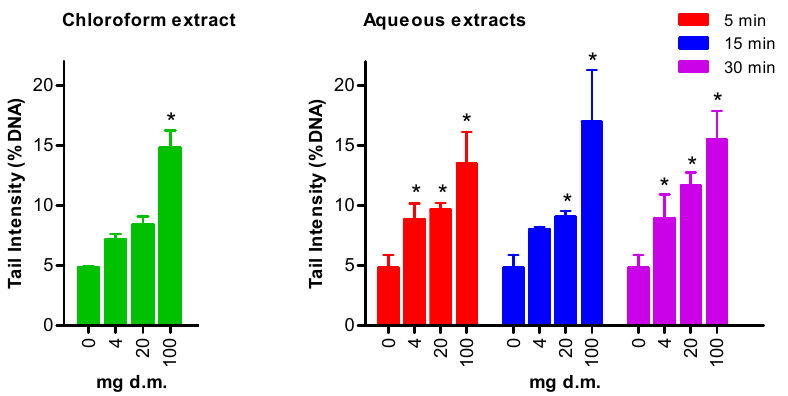
Figure 2. Primary DNA damage in HepG2 cells exposed for four hours to different concentrations of Senecium vulgaris chloroform and aqueous extracts. The extent of DNA strand breakage is expressed in terms of tail intensity (% DNA migrated in the comet tail). The results of each experimental set are summarized as the mean value of at least three independent experiments ( ± SEM). Statistical analysis: * indicates statistically significant differences ( p < 0.05) compared with the negative control, one-way ANOVA followed by Dunnett’s post hoc analysis. Tail intensity of positive control (1 µ M 4NQO): 18.55 ± 2.30. Exposure of HepG2 cells to S. vulgaris extracts significantly increased the extent of DNA damage in a concentration-dependent manner. This is quite clear in both chloroform and aqueous extracts, and, in the latter, this phenomenon is independent of the time of infusion. The highest concentration (100 mg d.m.) exerted a significant genotoxic effect in each extract (compared with the negative control), whereas 20 mg d.m. did so only in the aqueous extracts. Aqueous extracts obtained after 5 and 30 min of infusion induced pri- mary DNA damage at the lowest concentration tested (4 mg d.m.).